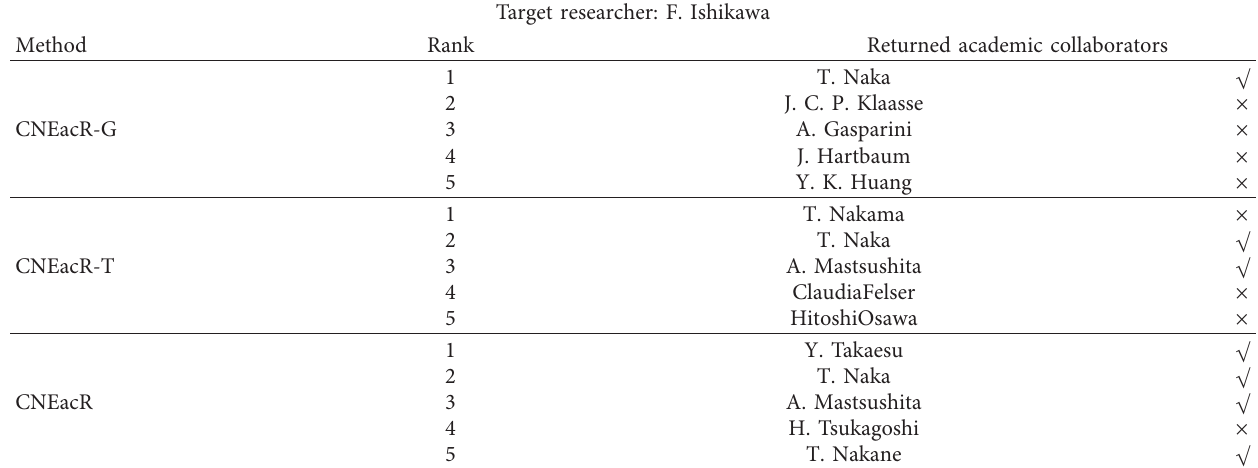
Table 5: Case study of different methods for collaborator